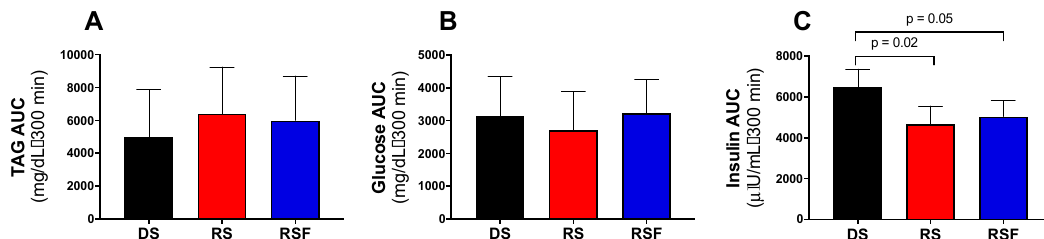
Figure 3. Post-Prandial Plasma Metabolites and Insulin. Change in plasma ( a ) triacylglycerides (TAG), ( b ) glucose, and ( c ) insulin concentrations relative to baseline (fasting) following consumption of a diet containing digestible starch (DS), resistant starch (RS), or resistant starch with high fiber (RSF). There was no effect of diet on incremental area under the curve (AUC) for TAG or glucose, but insulin AUC was significantly lower in RS and RSF relative to DS. Data are expressed mean ± SEM.